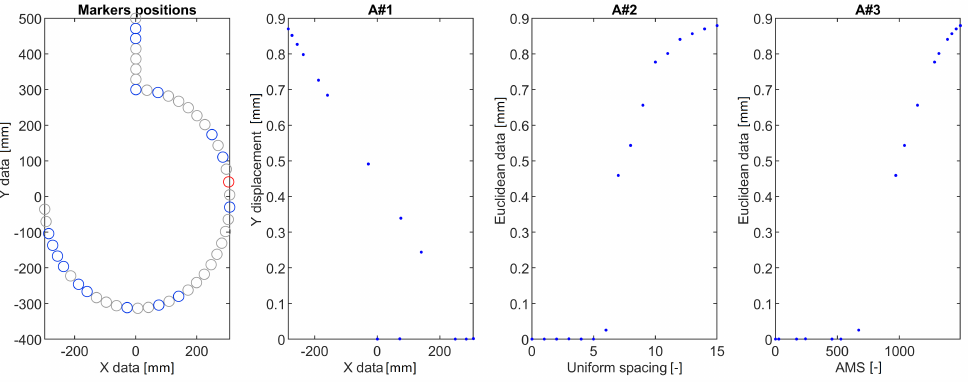
Figure 4. DDs for a hook structure calculated using the three tested approaches. Blue circles denote points used for evaluation. Grey circles denote points randomly excluded from measurement. The red circle denotes the damage location.